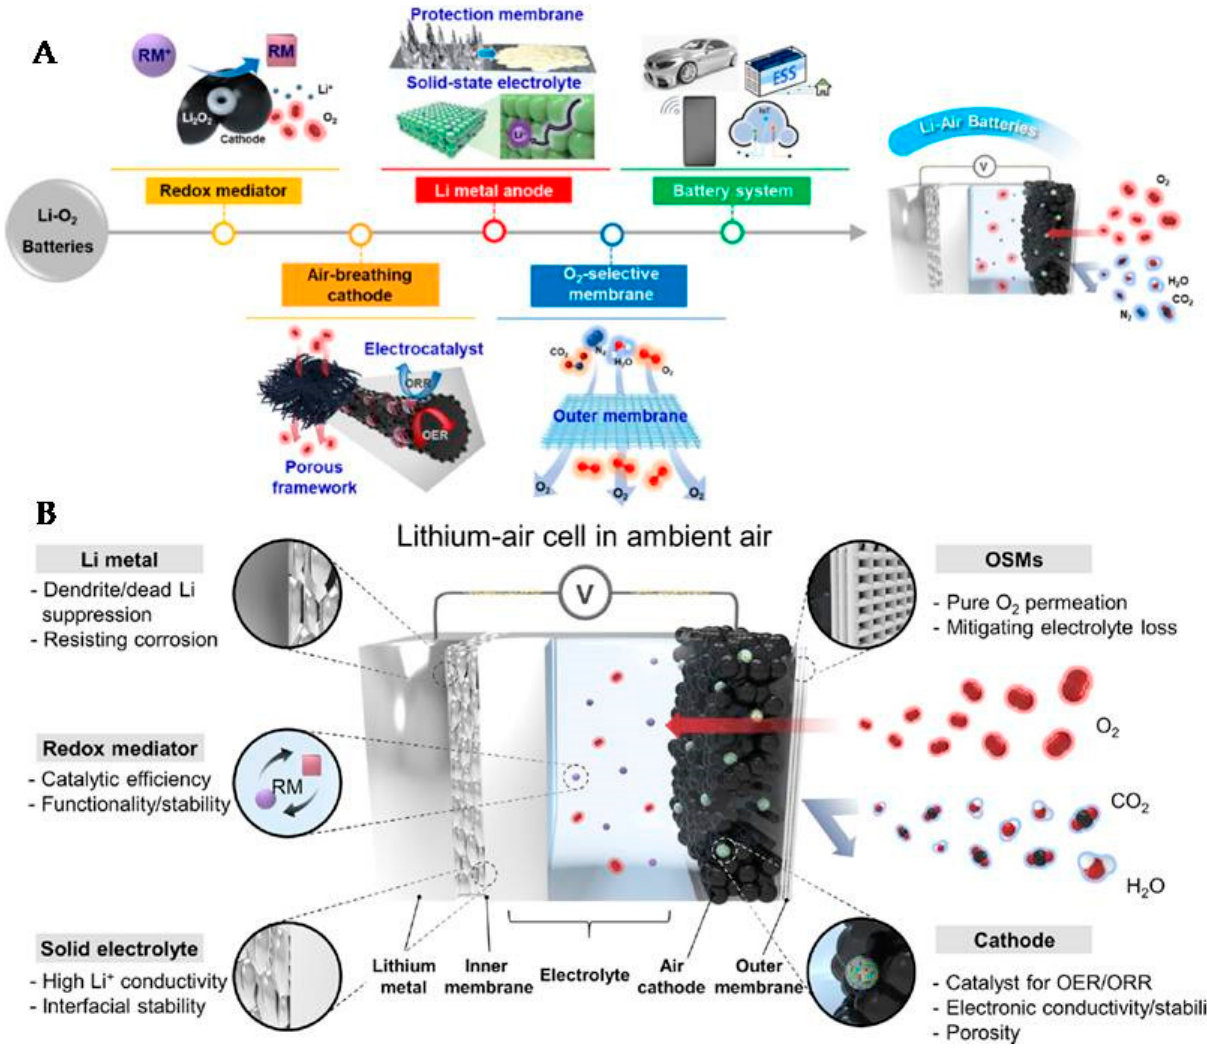
Figure 9. The systematic representation of the current challenges of the Li-Air batteries. ( A ) Projected challenges to make a better Li-Air battery. ( B ) Representation of the Li-Air battery and its components view and challenge at the site of each and every component. Reprinted/adapted with permission from ref. [184]. Copyright 2020, ACS.